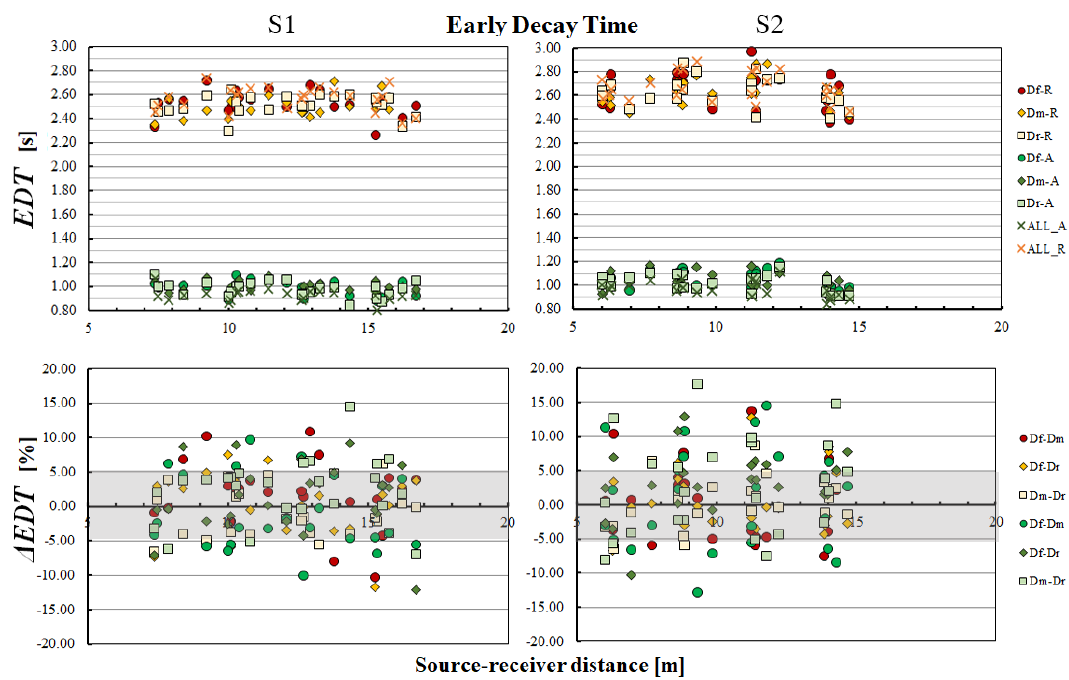
Figure 5. EDT parameter averaged over 500 Hz and 1000 Hz for S1 and S2 source-to-receiver distance. Δ EDT represents the parameter differences between the configurations Df-Dm, Df-Dr, Dm-Dr in the reflective (-R) and absorptive (-A) conditions. Differences equal ±1 JND of the parameters are highlighted through a gray area.